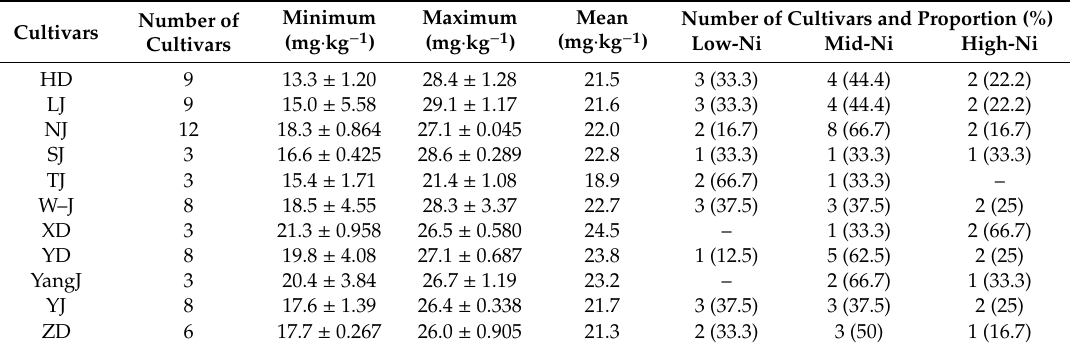
Table 2. Ni concentrations in shoots of rice subgroups from Jiangsu Province. Note: The low Ni-accumulating (low-Ni) and high Ni-accumulating (high-Ni) cultivars are defined as the 20 lowest and 20 highest shoot Ni-accumulating genotypes among the 72 cultivars, respectively. The other 32 cultivars are defined as middle Ni-accumulating (mid-Ni) cultivars. The subgroup W – J comprised two WJ, five WYJ, and one WXJ cultivars. Data are means ± standard deviation (n = 3).